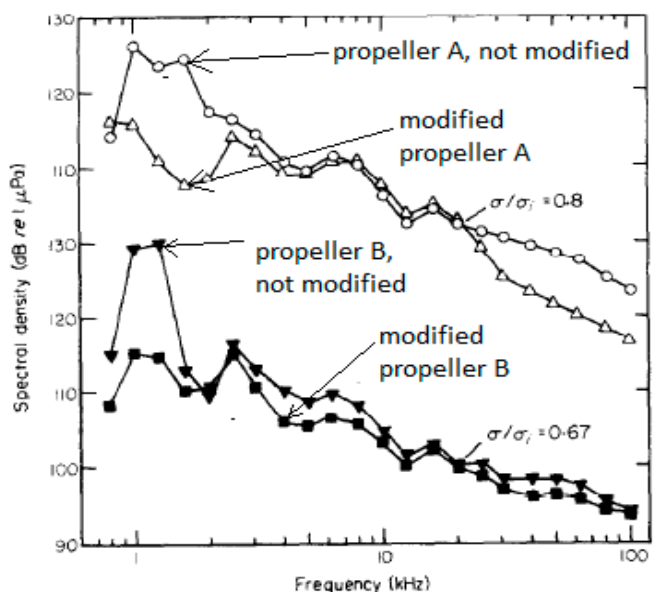
Figure 1. Influence of blade modification on cavitation noise for J = 0.38. Reproduced from [12] with permission from Elsevier, 1990.